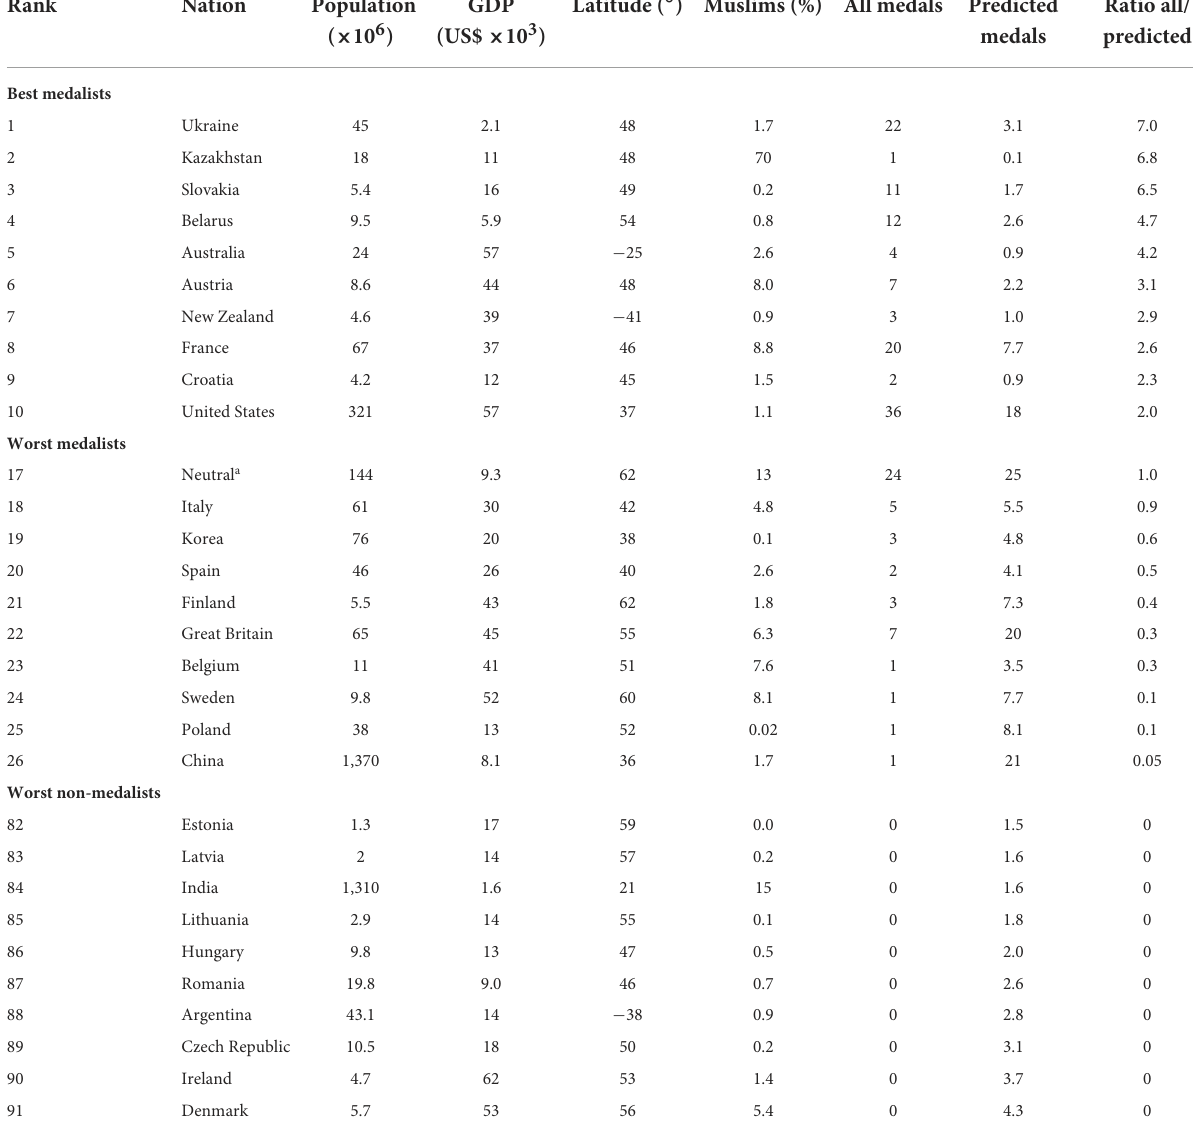
TABLE 9 Ranking of the best medalists, worst medalists and worst non-medalists at the Pyeongchang winter Paralympics. Rank Nation Population